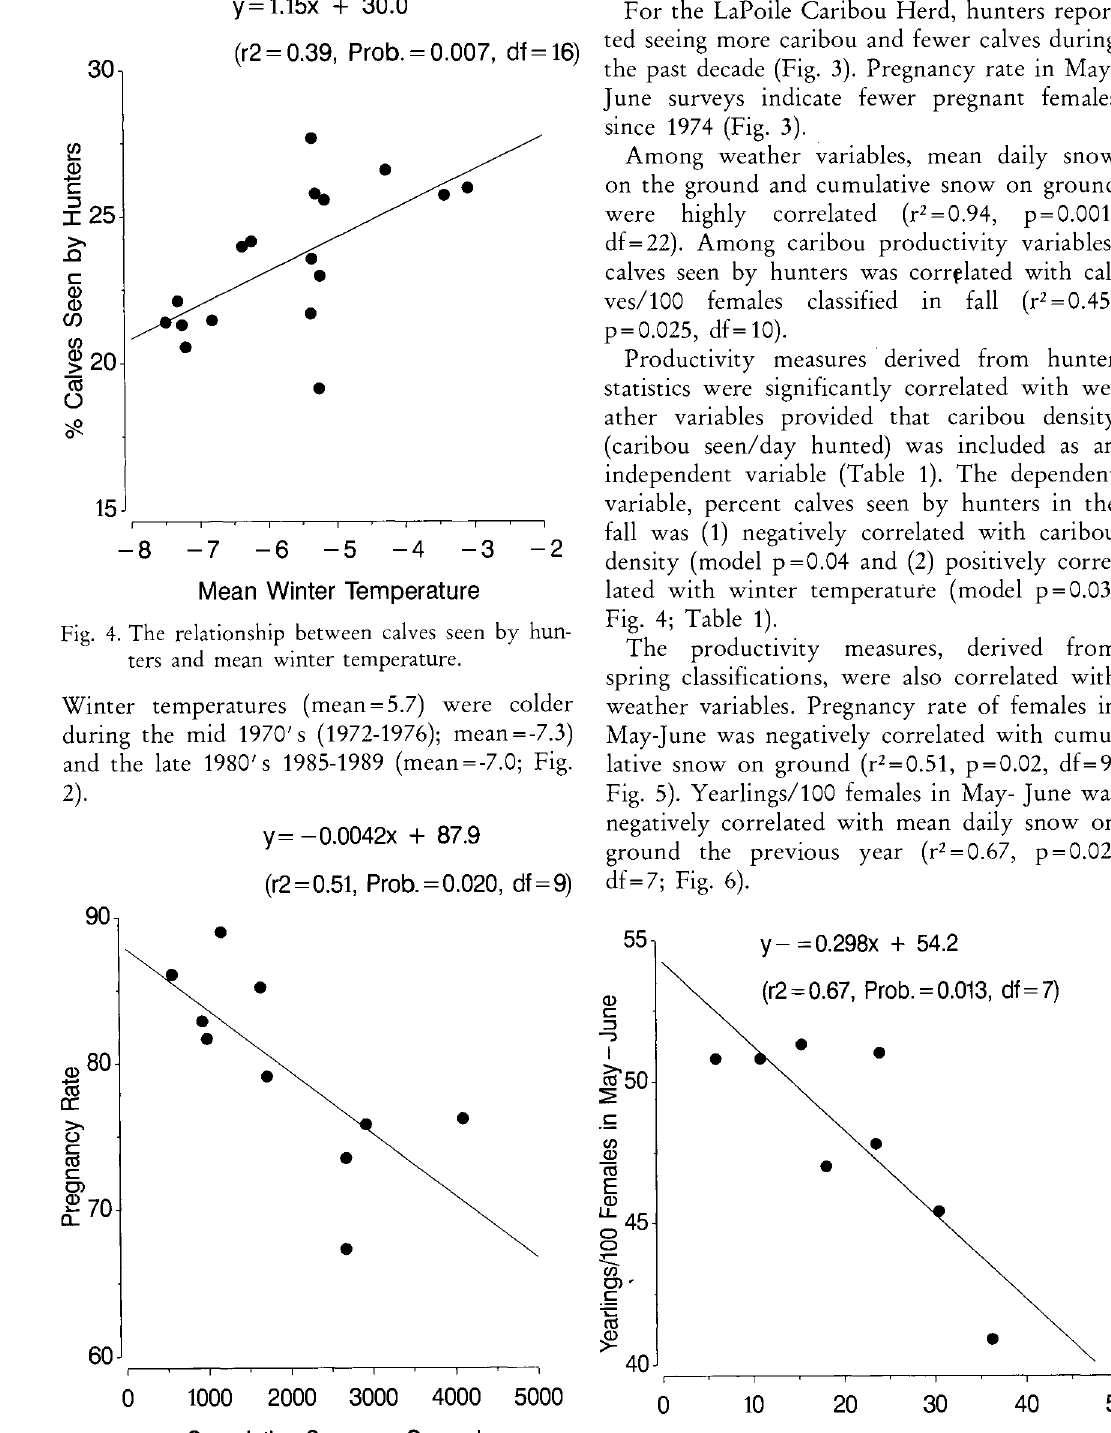
Fig. 5. The relationship between female pregnancy rate and cumulative snow on the ground (1000 cm) that winter.